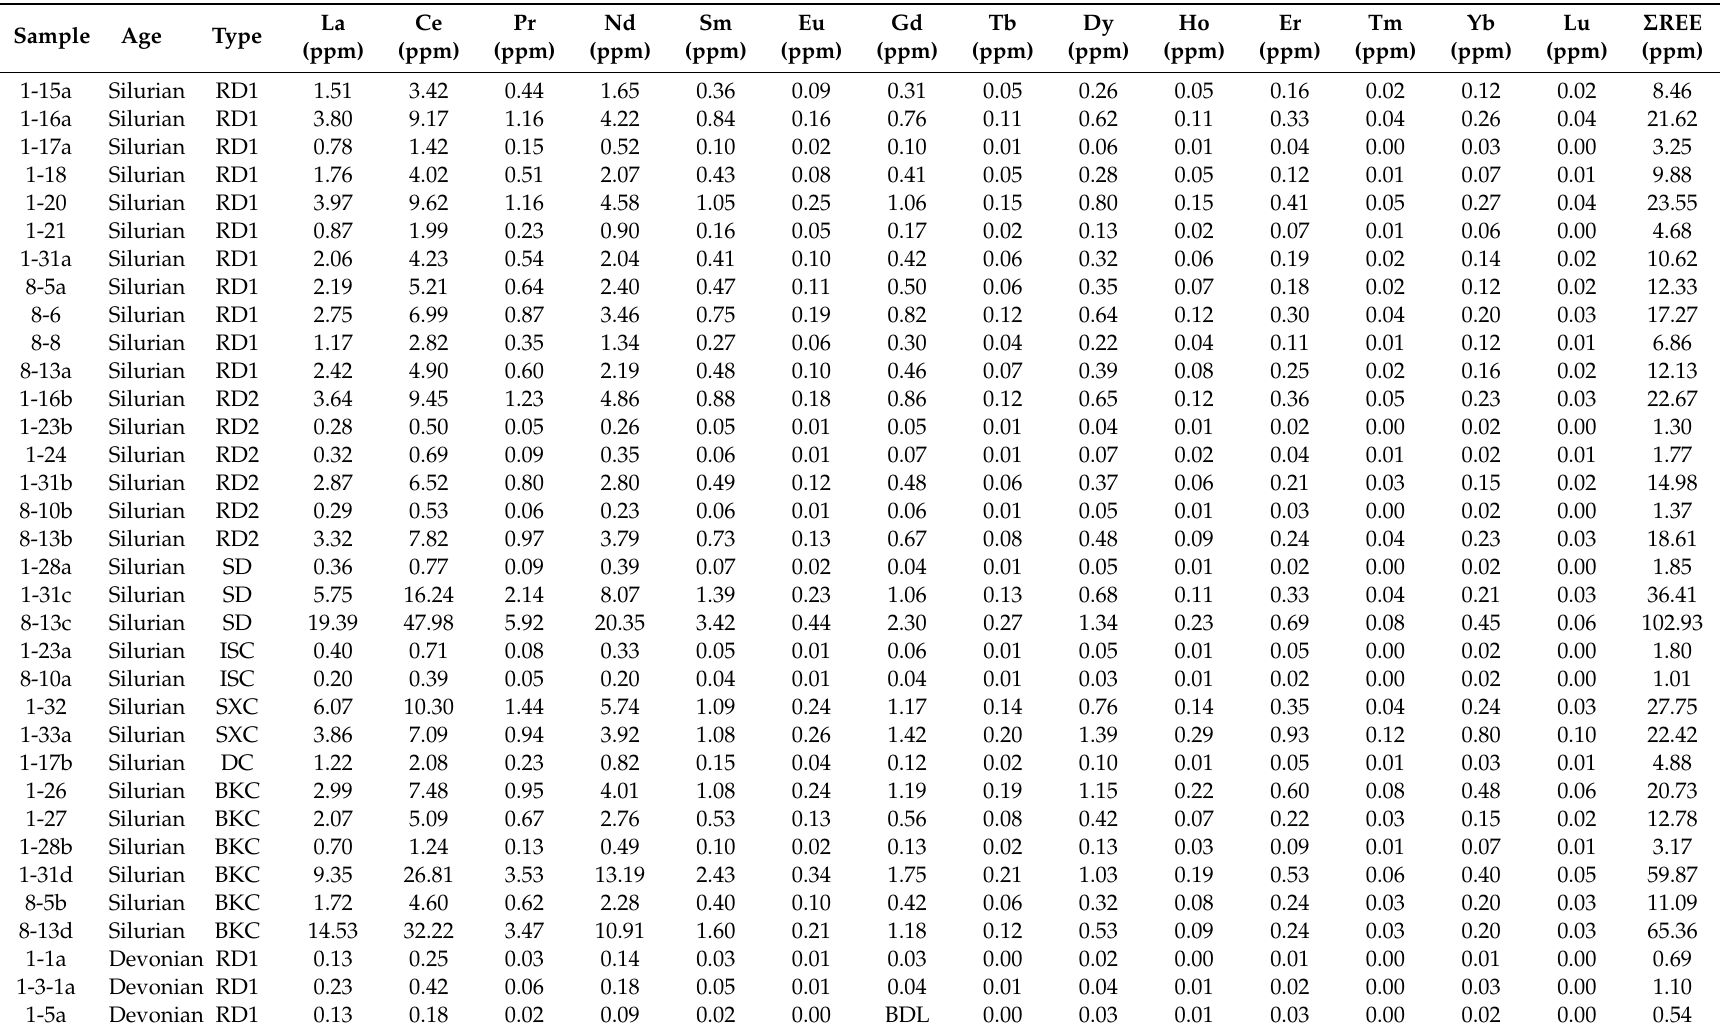
Table 6. Rare earth elements (REE)